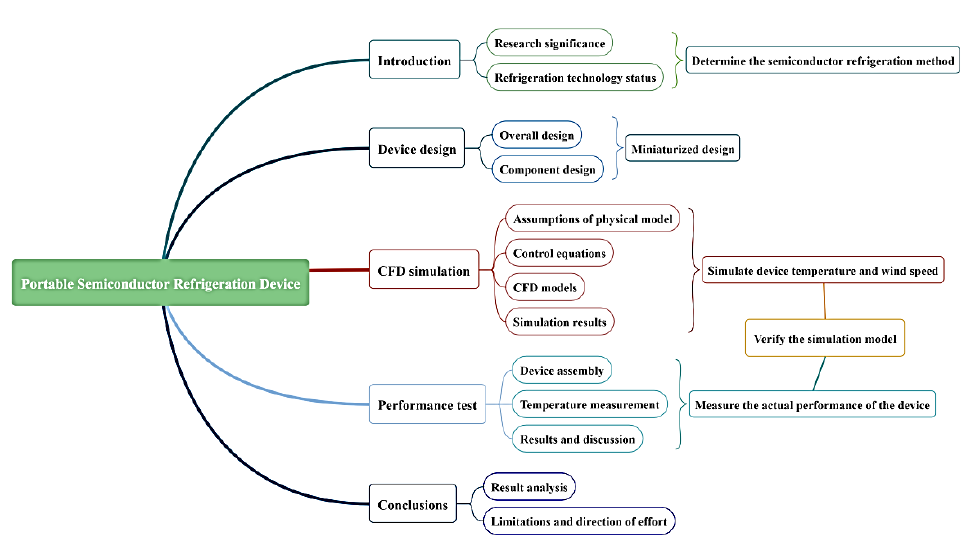
Figure 6. The workflow of portable refrigeration device in this paper.